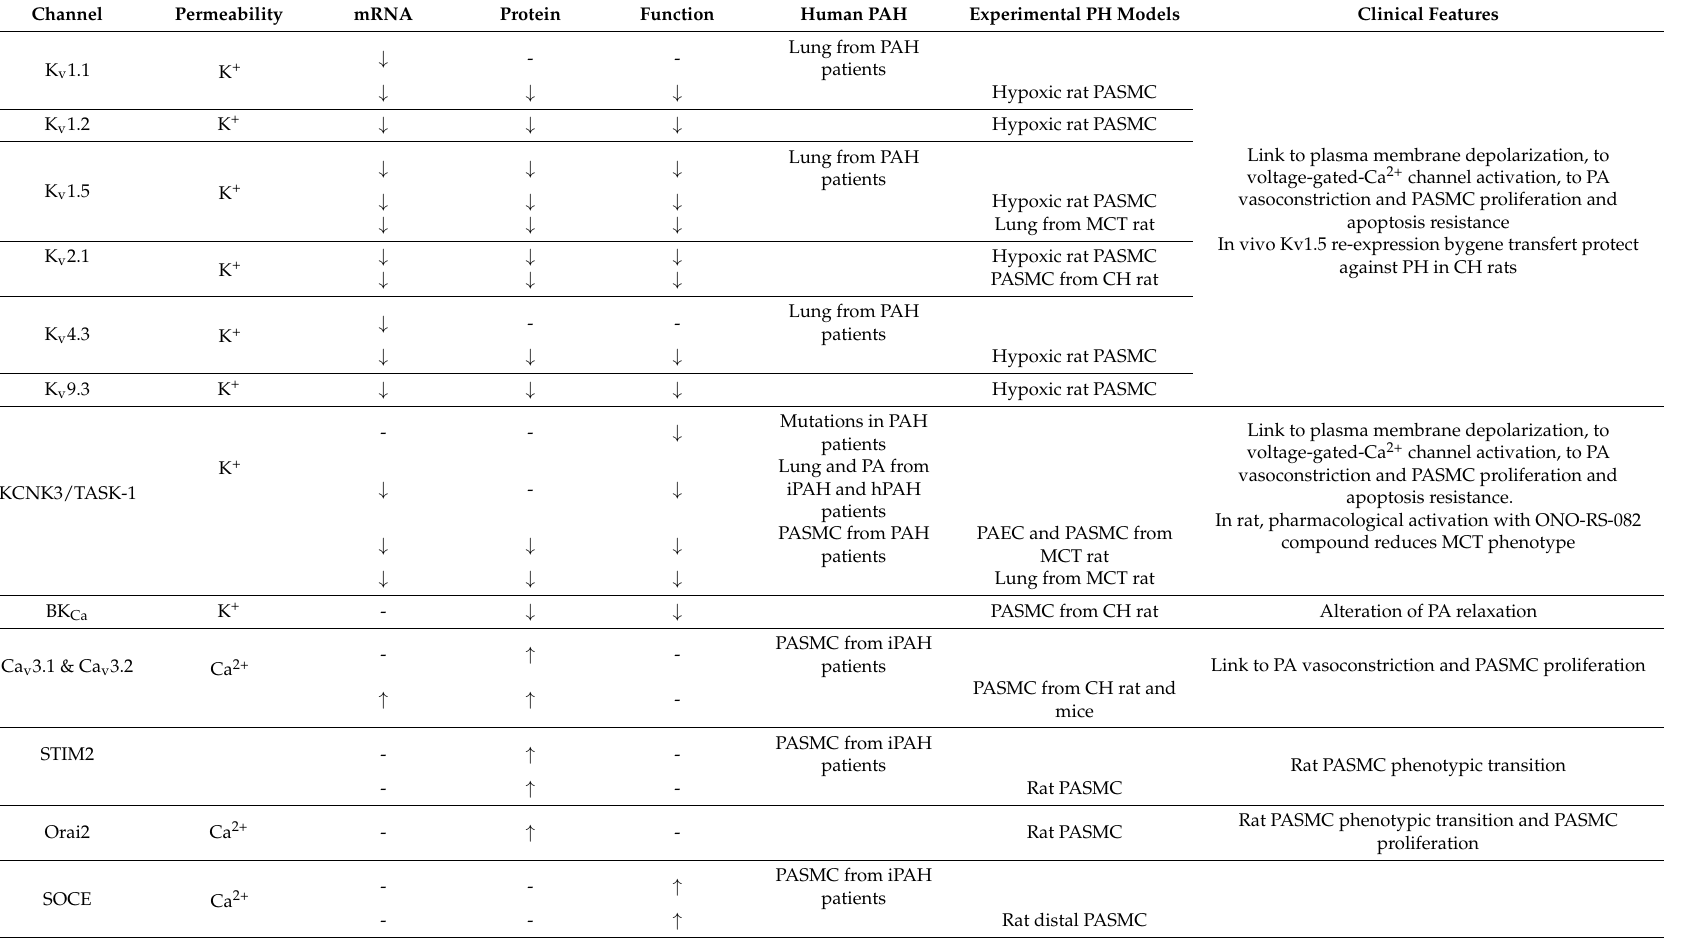
Table 2. Functional impact, changes in the mRNA, protein and function of ion channels reported in PAH and in different models of PH. Upward and downward pointing arrow show increase and decrease, respectively; -, no available information. Experimental PH Models Clinical